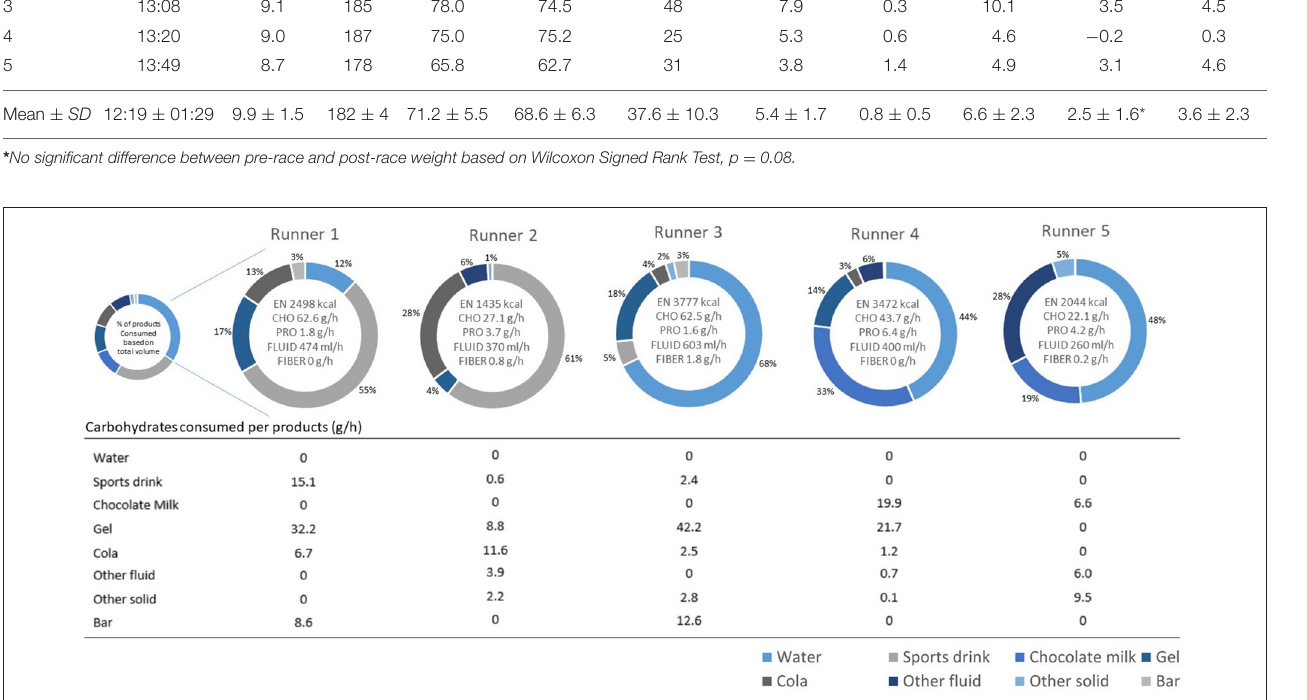
FIGURE 1 | Total energy and nutrient intake per hour, percentage (%) volume of total consumed food groups, and carbohydrate intake (CHO) per food group in g/h per runner.